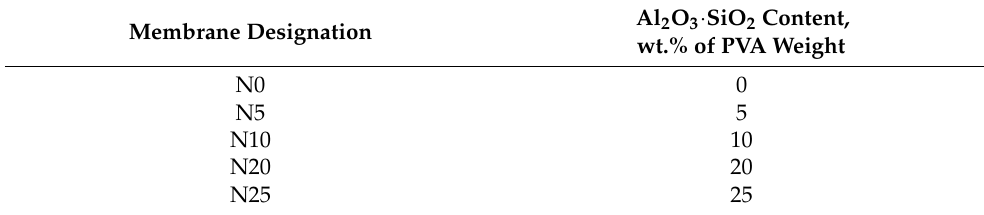
Table 6. Membrane designations and preparation